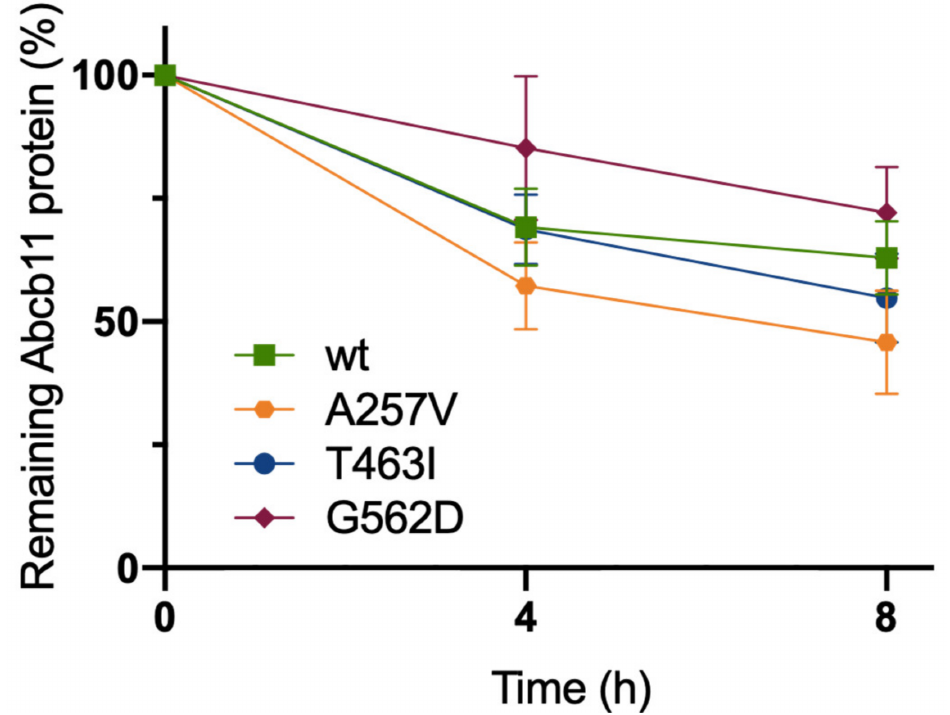
Figure 3. Abcb11 variants do not display significant stability defect. MDCK cells stably expressing Abcb11-GFP (wt or variants) were treated with cycloheximide (25 µ g/mL) to inhibit protein synthesis. Then, expression of Abcb11-GFP (wt and variants) was analyzed using immunoblot at the indicated time points (Figure S1). Electrophoretic patterns of Abcb11-GFP were separately quantified at 0, 4 and 8 h after cycloheximide addition, and their relative amounts were calculated and normalized to α -tubulin. The amount of Abcb11-GFP at time 0 was considered as 100%. Remaining Abcb11-GFP after 4 and 8 h of treatment was expressed as a percentage of time point 0. Means ( ± SEM) of three independent experiments are